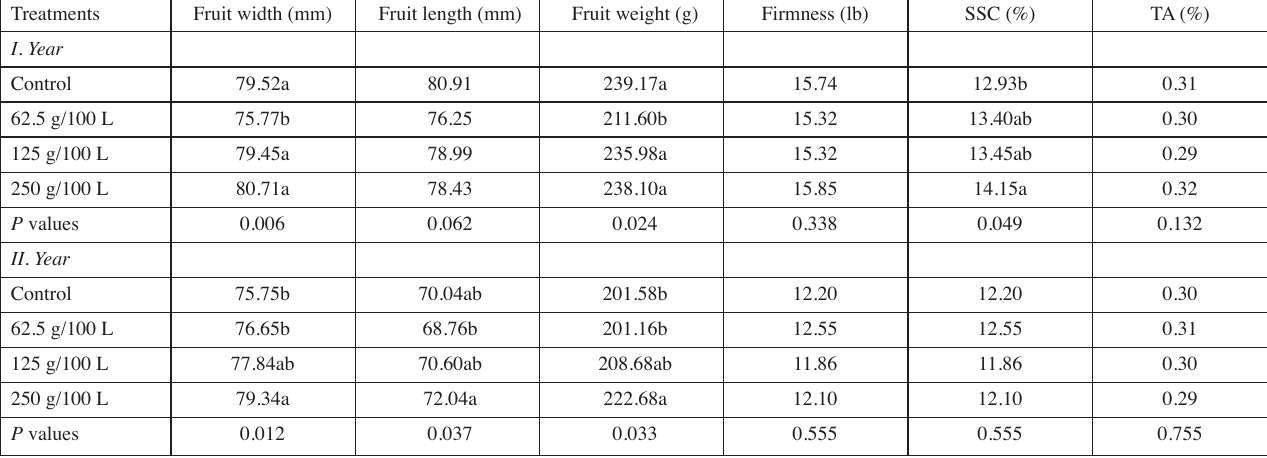
Tab. 3: The effect of Pro-Ca dosage on some fruit characteristics in the ‘Starcrimson’ apple cultivar Treatments